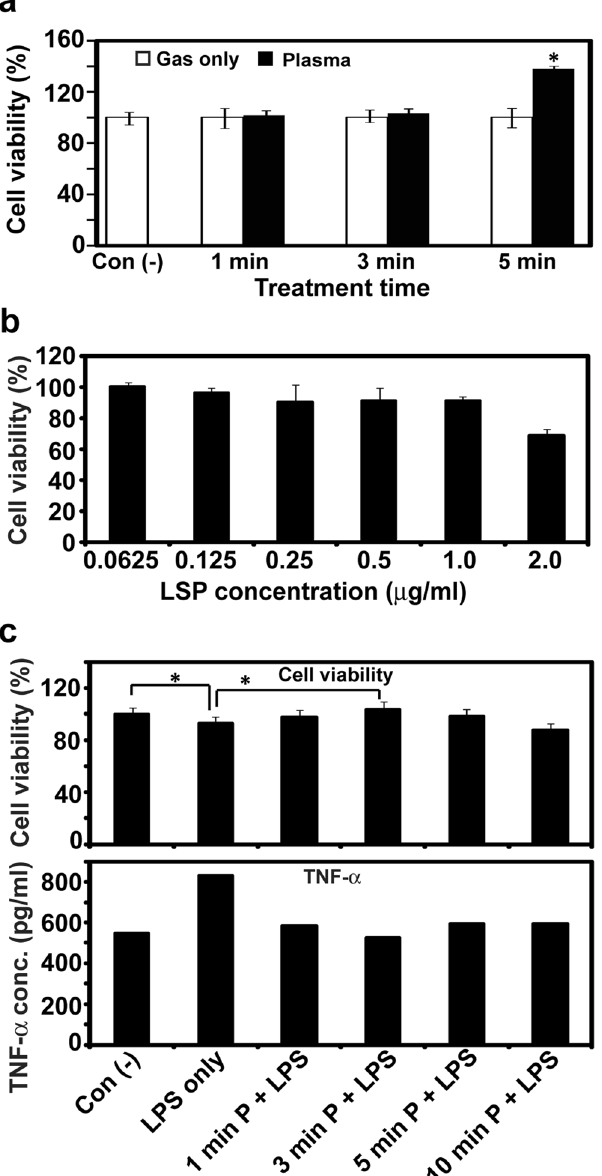
were performed nine times. ( b ) Viability of HGFs stimulated with a range of lipopolysaccharide (LPS) concentrations. All measurements were performed three times. ( c ) Viability and tumor necrosis factor alpha release by HGFs treated or not with plasma (1 min, 3 min, 5 min, and 10 min) after 1.0 µ g/ml LPS stimulation; * P < 0.05 vs con( − ) (no LPS or plasma). All measurements were repeated eight